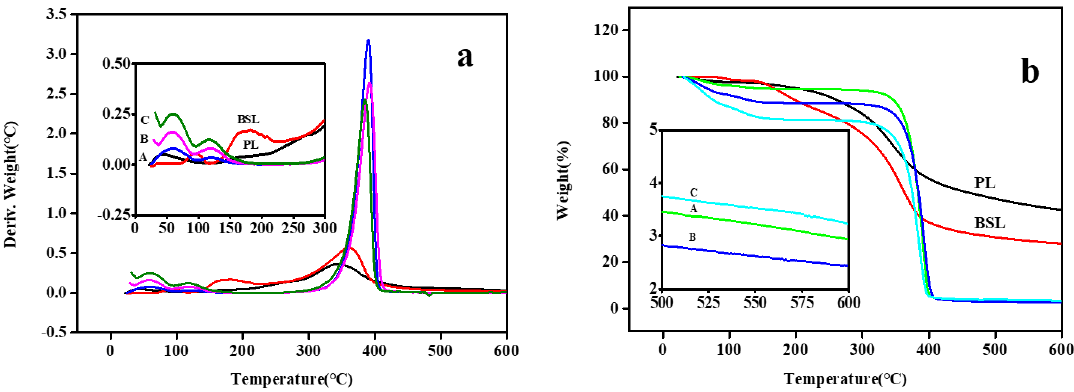
Figure 5. DTG ( a ) and TG ( b ) curves of PL, BSL, and the gel. Table 3. Thermal properties, compression strength, surface area, and pore size of samples